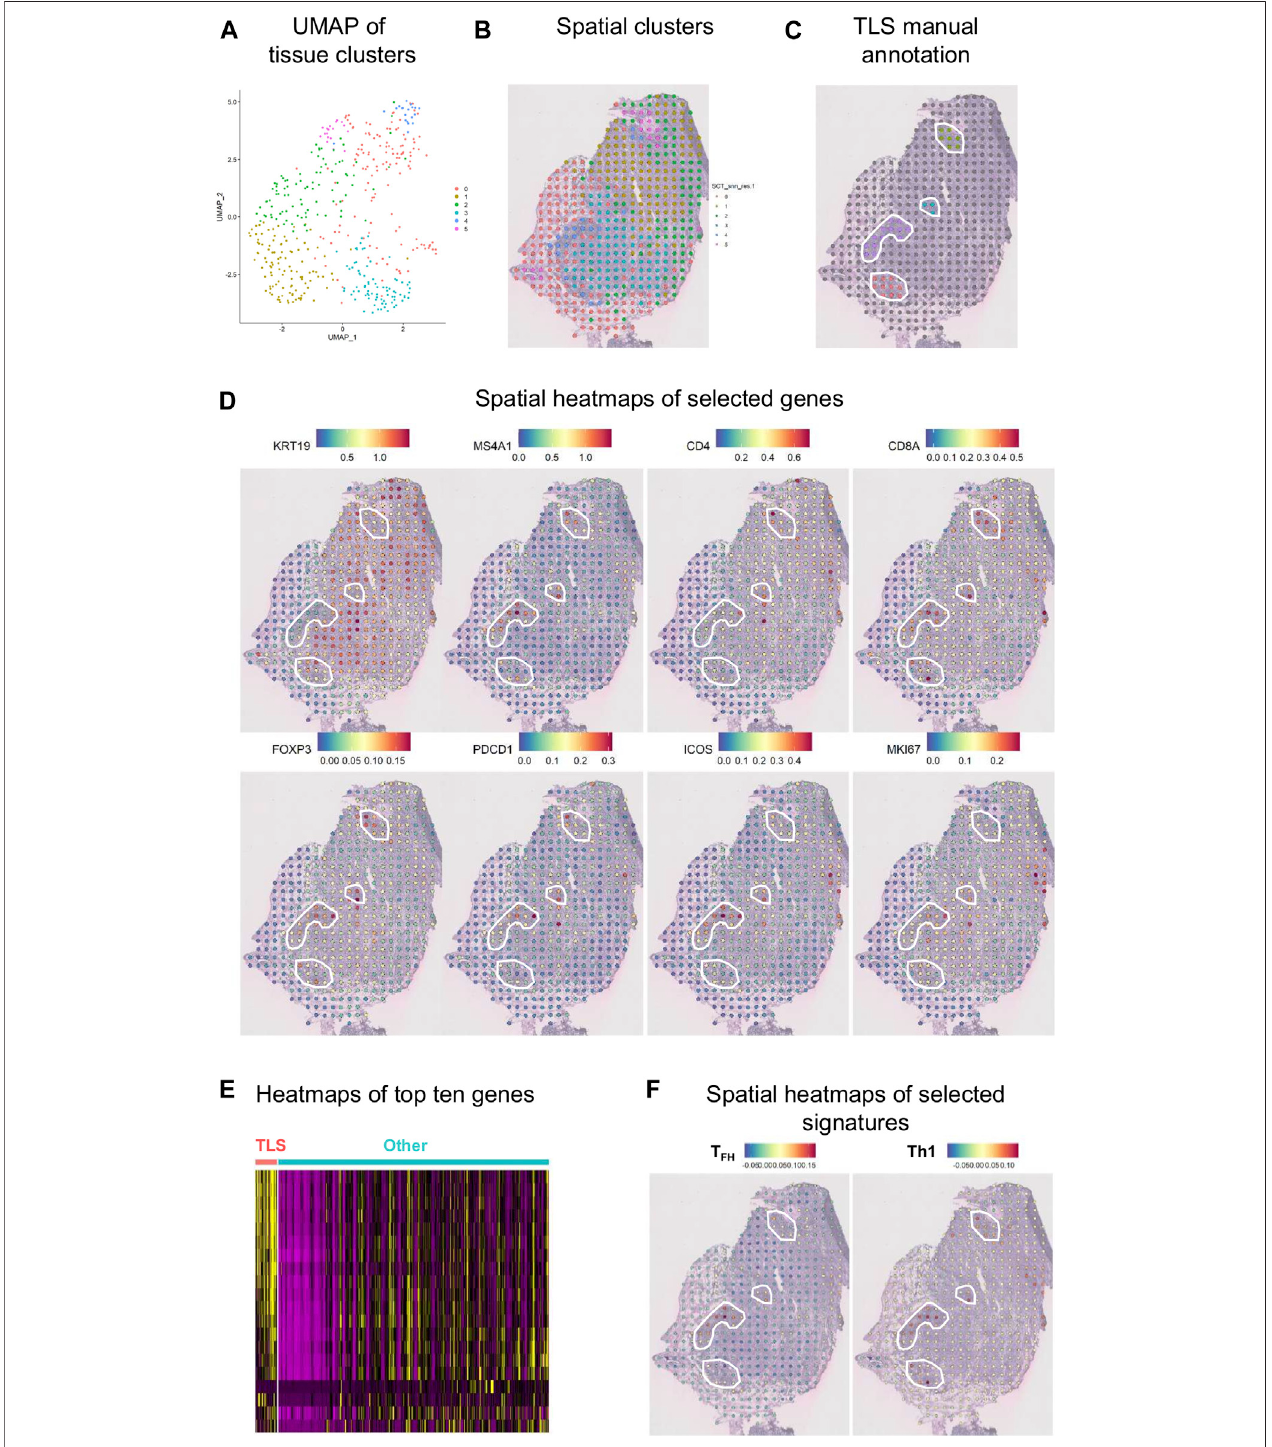
FIGURE 8 | Spatial gene expression in breast cancer. (A) UMAP representation of global gene expression in individual spots from a fresh-frozen section of an invasive lobular carcinoma created fi ve distinct clusters with unbiased Seurat clustering. (B) The features were placed back onto the H&E staining. (C) Four TLS were histologically annotated on bright fi eld images of H&E-stained tissue sections (white line). (D) Visualization of eight selected genes as spatial heatmaps. (E) A heatmap of the top ten differentially expressed genes in the annotated TLS compared with the remaining tumor tissue. (F) Spatial heatmaps of T FH and Th1 signatures.